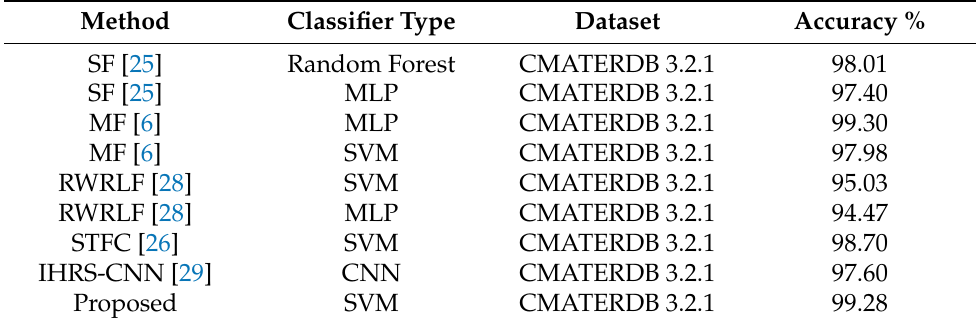
Table 5. Comparison between the proposed method and the state-of-the-art methods for Devanagari numeral recognition in clean environment.